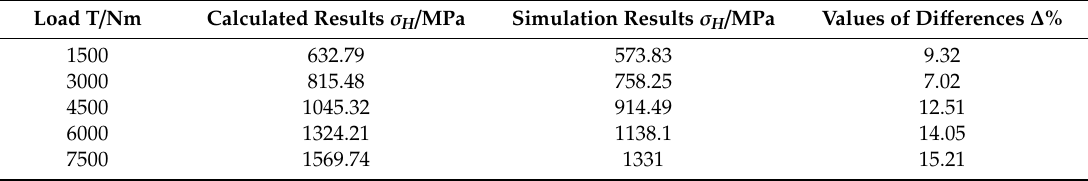
Table 3. Results comparison of FEM and empirical formula of maximum contact